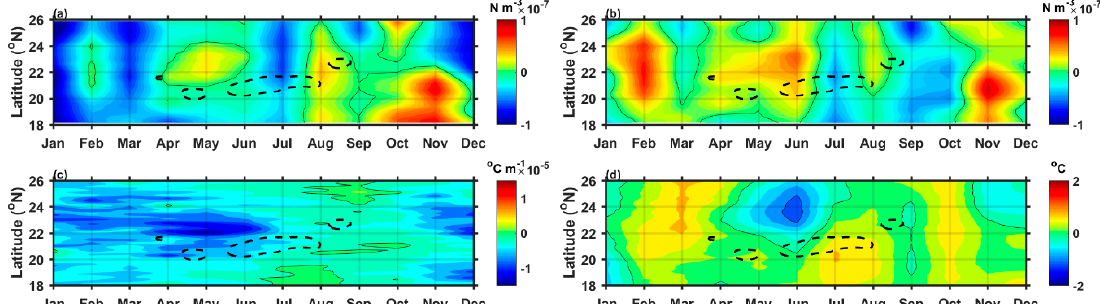
Figure 10. Hovmöller diagram of ( a ) surface wind stress curl, ( b ) surface wind stress curl anomalies, ( c ) meridional gradient of SST, and ( d ) SST anomalies, calculated from the monthly meridional profiles zonally averaged within 125 ◦ and 135 ◦ E, based on the CCMP wind and OISST data gridded at 1/4 ◦ and 0.05 ◦ resolution, respectively. Thin solid curves show zero contours. Dashed curves show the contour of zonal geostrophic-current velocity at 0.2 m s − 1 . The monthly anomalies are herein referred to the monthly climatological fields from 1998 to 2018 due to the available CCMP wind data.